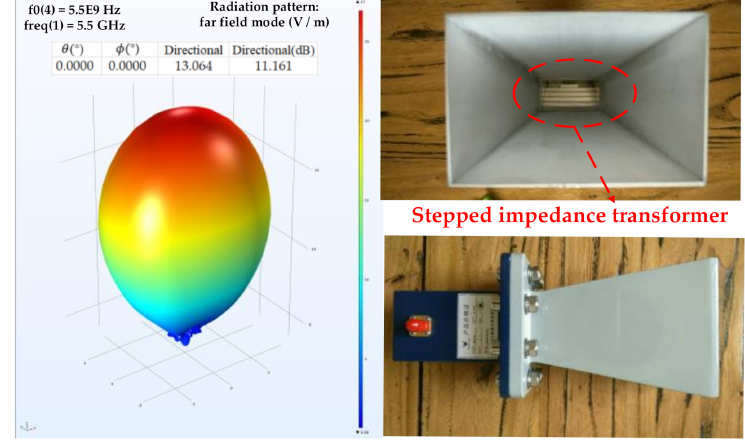
Figure 5. Radiation field distribution, directivity gain, stepped impedance transformer and antenna physical picture of horn